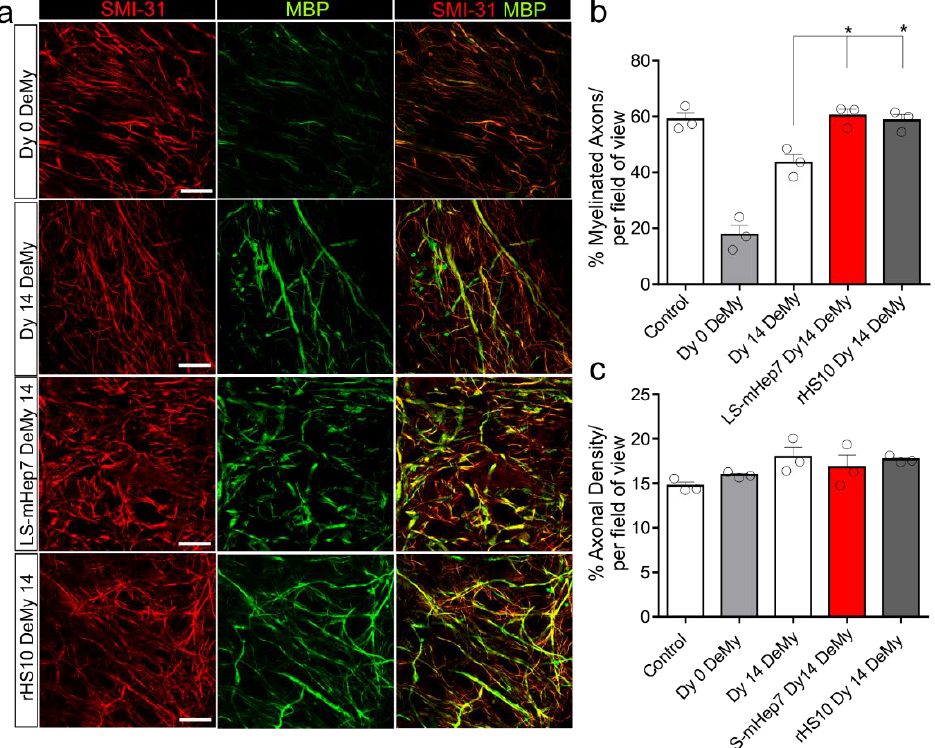
Figure 2. rHS10 and LS-mHep7 enhances remyelination after lysolecithin induced demyelination of ex vivo spinal cord slice cultures. Spinal cord slice cultures after 14 DIV were demyelinated using lysolecithin for 20 h (Dy 0 DeMy). Slices were then treated with either LS-mHep7 or rHS10 at 100 ng/mL or in standard culture media as a control every other day for further 14 DIV. ( a ) Representative images of slice cultures. MBP stains myelin in green and SMI-31 stains axons in red. Scale bar represents 100 μ m. ( b ) The percentage of myelinated axons per field of view was enhanced significantly in both LS-mHep7 (LS-mHep7 DeMy 14) and rHS10 (rHS10 Dy 14 DeMy) treated slices compared to untreated controls (Dy 14 DeMy) ( c ). Axonal density per field of view remained unchanged across the treatments. (n number represented by individual circle data points. ANOVA with Dunnett multiple comparison * p < 0.05).